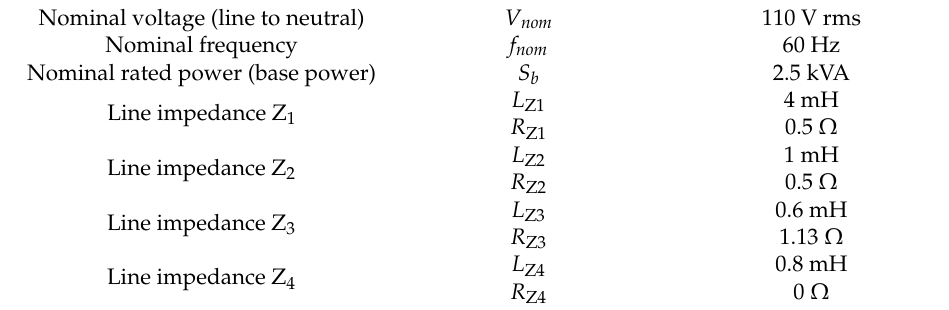
Table 1. Hardware